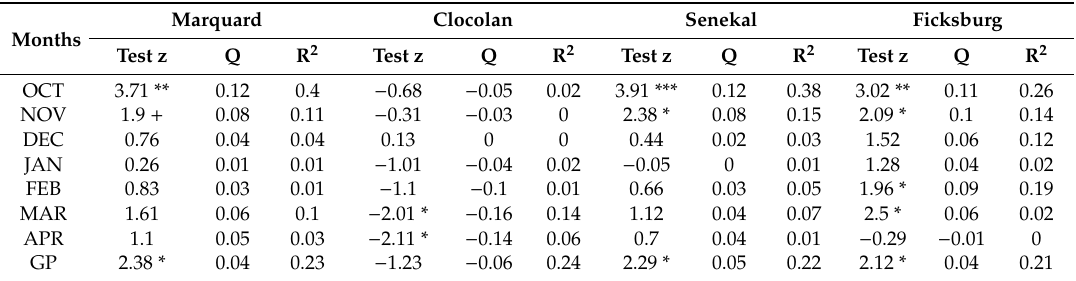
Table 6. Monthly Maximum Temperature ( ◦ C) annual trends during the growing period for the study period from 1985–2016. Mann Kendall MK Test Z denote Mann Kendall trend analysis test, and Q denotes ‘the Sen’s slope estimate’ for the Setsoto municipality.